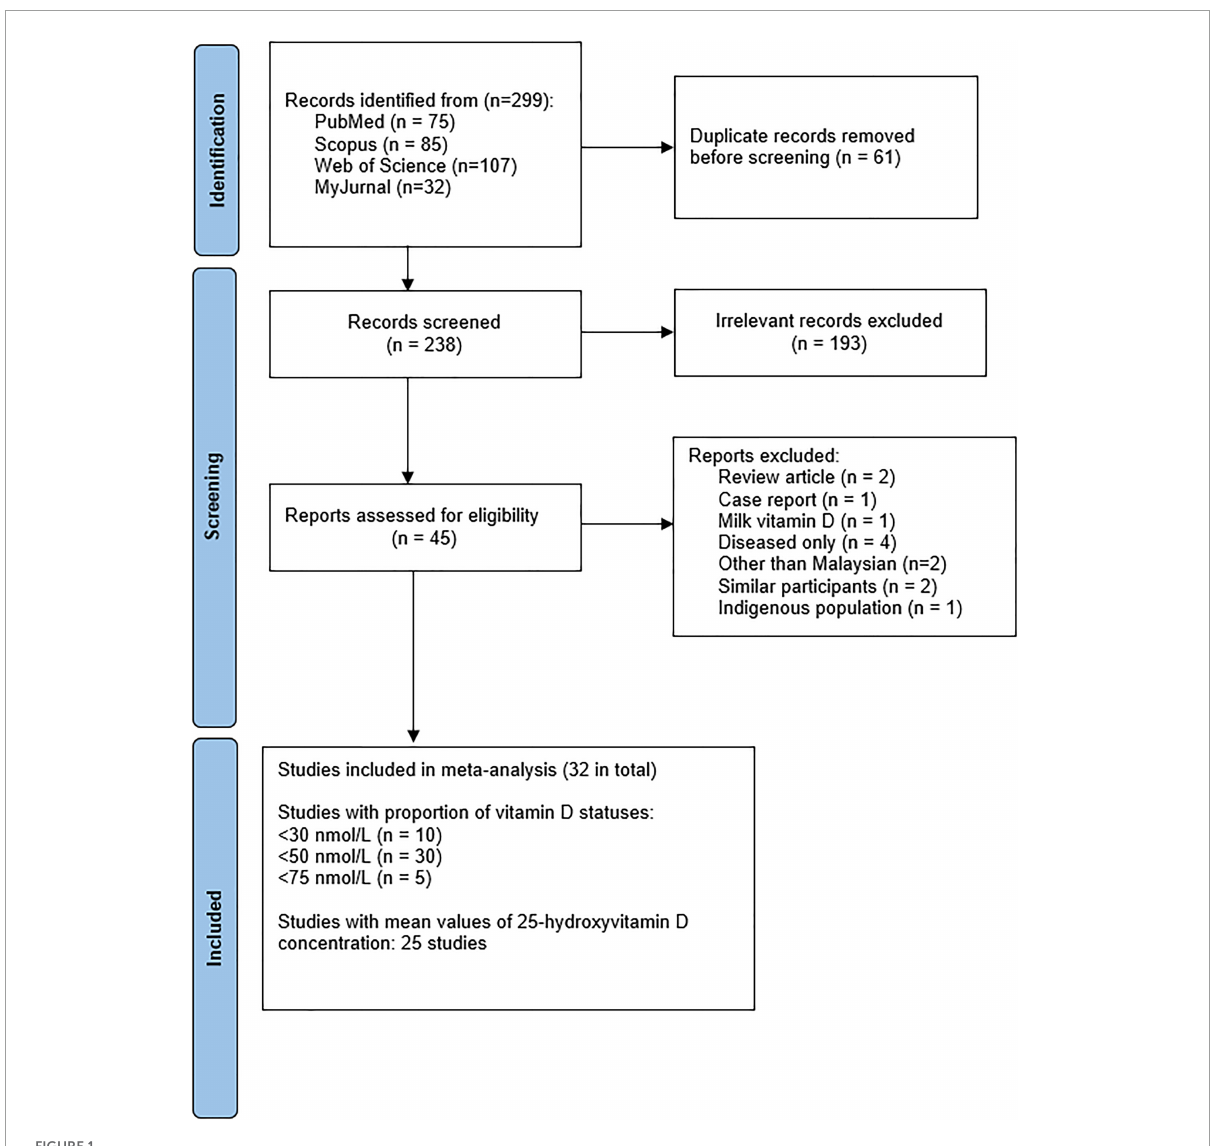
FIGURE1 Flow-chart of study